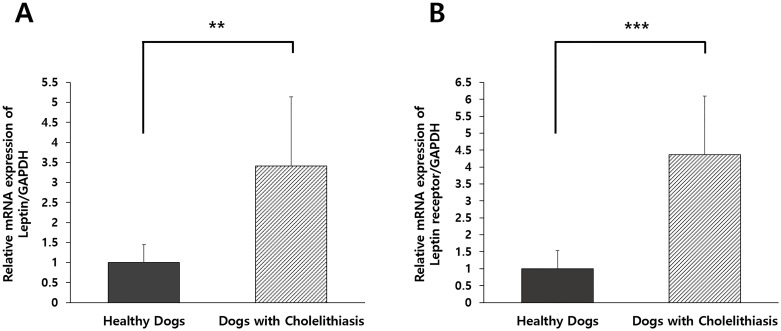
Relative mRNA expression levels of leptin and leptin receptor in gallbladder tissues.The mRNA expression levels of (A) leptin and (B) leptin receptor were significantly higher in patients with cholelithiasis (n = 10) than in the controls (n = 10). Columns indicate mean values, and vertical error bars represent standard deviation. **p < 0.01, ***p < 0.001 between groups.